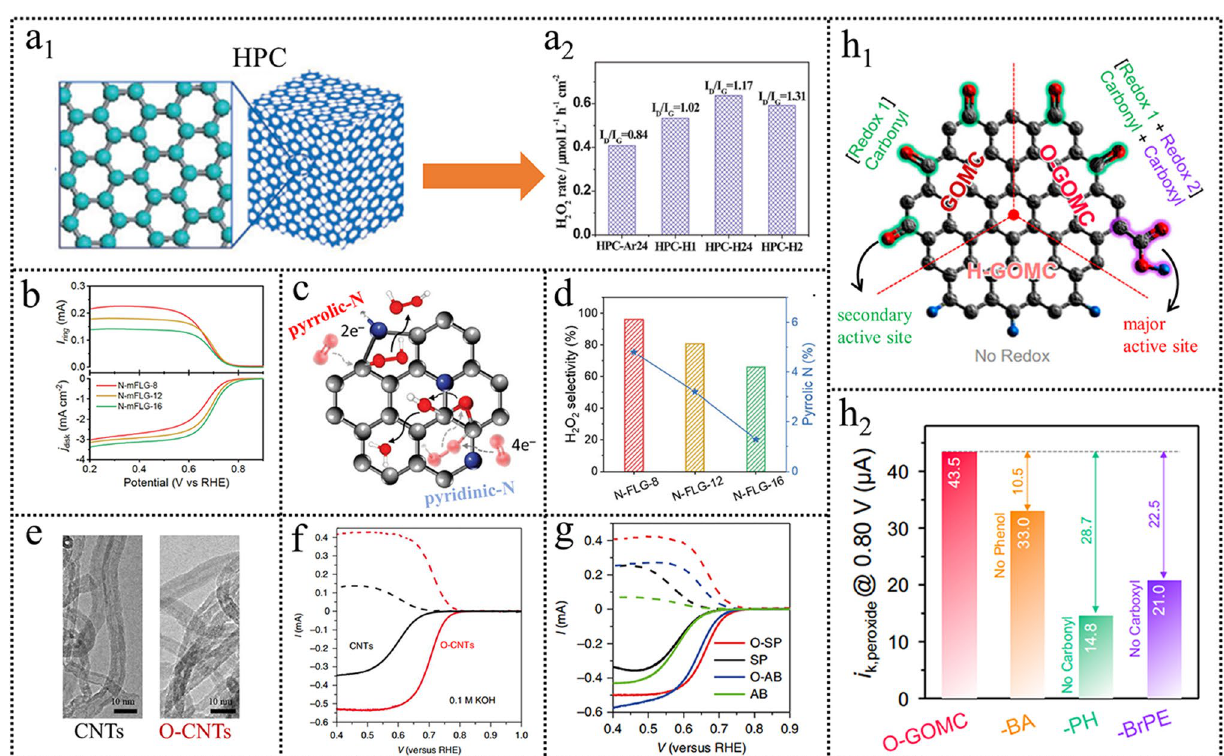
Fig. 12 a Schematic illustration of HPC materials and their H 2 O 2 production rates. Reproduced with permission [131]. Copyright 2015, Wiley. b ORR performance of N-FLG-8, N-FLG-12, and N-FLG-16. c Schematic diagram of two-electron and four-electron ORR pathways on N-FLG with different nitrogen configurations. d Relationship between H 2 O 2 selectivity and atomic content of pyrrolic-N. Reproduced with permission [141]. Copyright 2020, Wiley. e TEM images of CNTs and O-CNTs. f ORR performance comparison of CNTs and O-CNTs. g ORR perfor- mance comparison of SP, O-SP, AB, and O-AB. Reproduced with permission [146]. Copyright, 2018, Springer Nature. h Illustration of active species in H-GOMC, GOMC, and O-GOMC. Reproduced with permission [132]. Copyright 2021, Elsevier. (Color figure